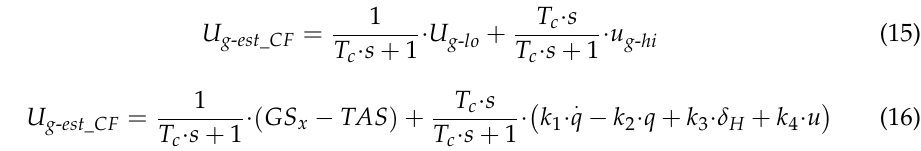
2.3. The Use of a Non-Linear Complementary Filter for Estimation of Headwind Gusts The general structure of an NCF (Figure 4) consists of low- and high-frequency inputs of the composite signal.